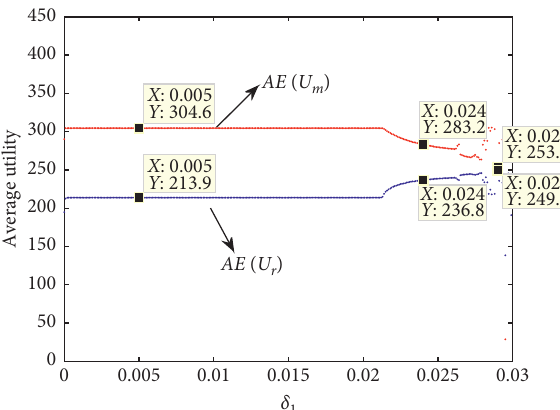
Figure 15: The average utility diagram with δ